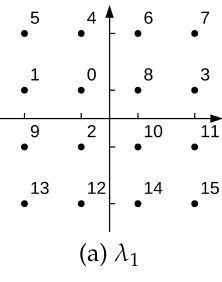
Figure 2. Illustration of constellations λ 1 and λ 2